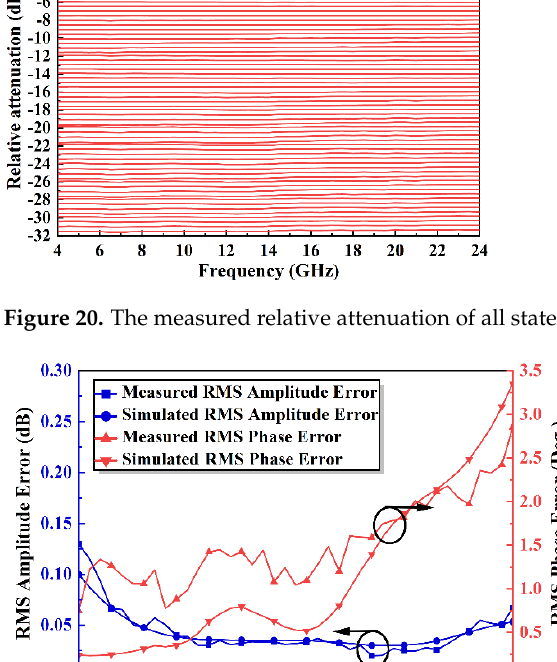
Figure 19. The measured ( a ) 𝑆 11 and ( b ) 𝑆 22 of all states.